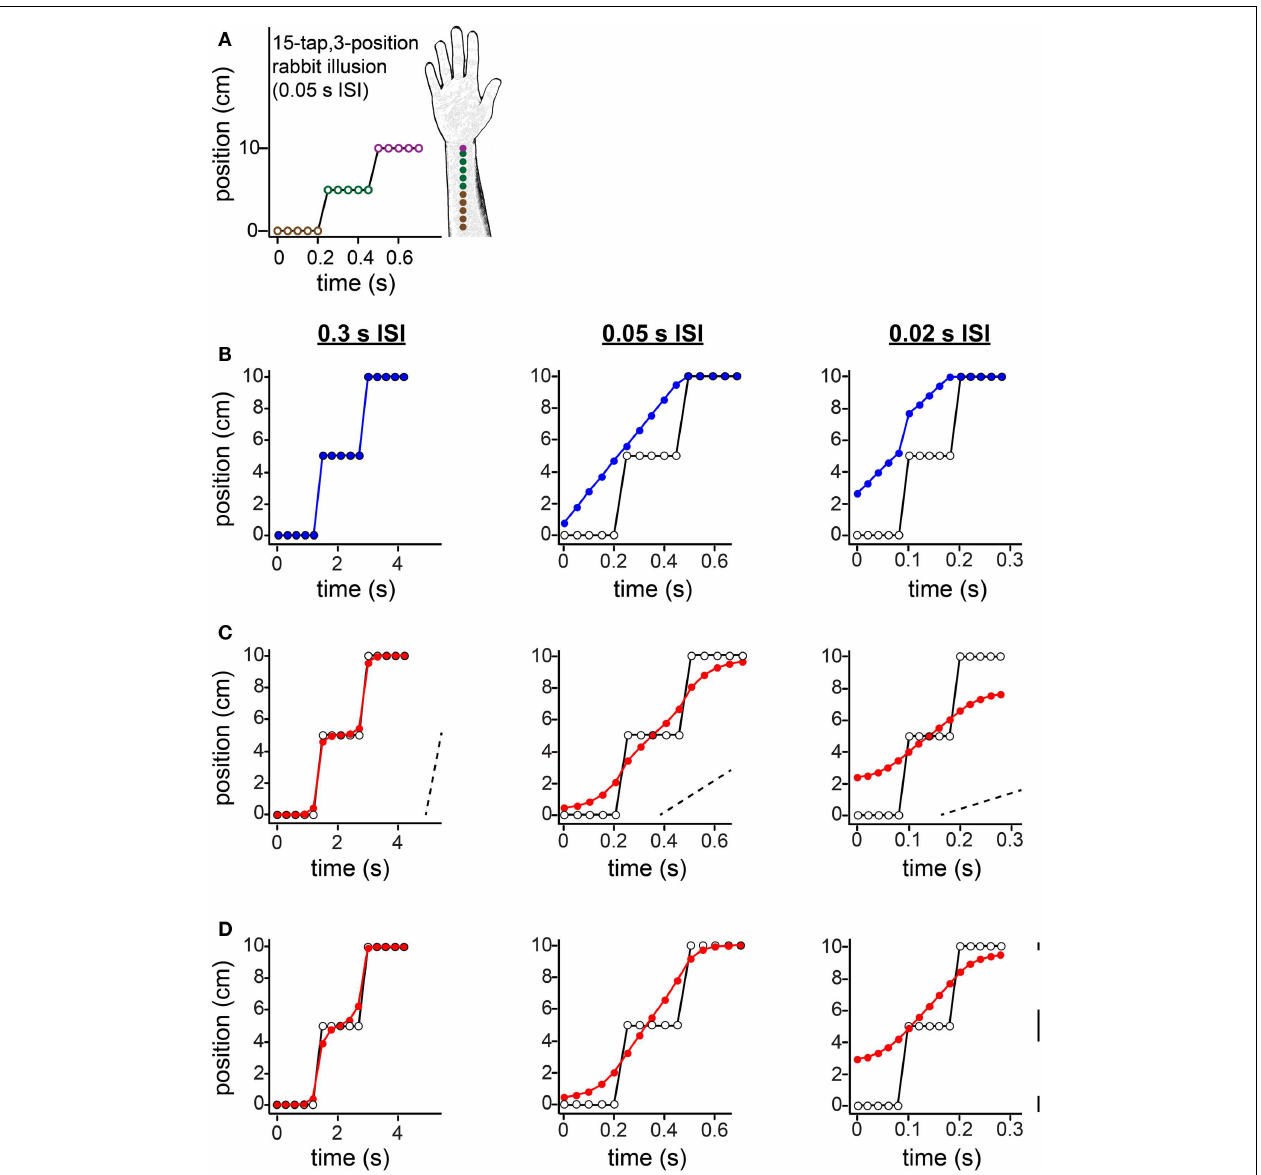
red points: Bayesian observer’s perception (mode of the posterior). Dashed slanted lines have slope 10cm/s (i.e., 1 σ v ). Note that the two rapid jumps in the true trajectory (from tap 5 to tap 6, and from tap 10 to tap 11) occur at a speed much greater than σ v when the ISI is 0.05s ( center ) or 0.02s ( right ); thus, perceptual length contraction occurs in these cases. In contrast, at an ISI of 0.3s ( left ), the trajectory does not strongly violate the observer’s low-speed expectation; thus, perception is nearly veridical. (D) The Bayesian low-speed observer’s perception can be made even closer to human reports if the value of σ s varies along the arm.The observer’s percept at each ISI is shown for σ s = 1, 2, and 0.5cm around the proximal, middle, and distal arm regions, respectively. Line segments at right have length equal to 1 σ s at each location.The value of σ v was fixed at 10cm/s.